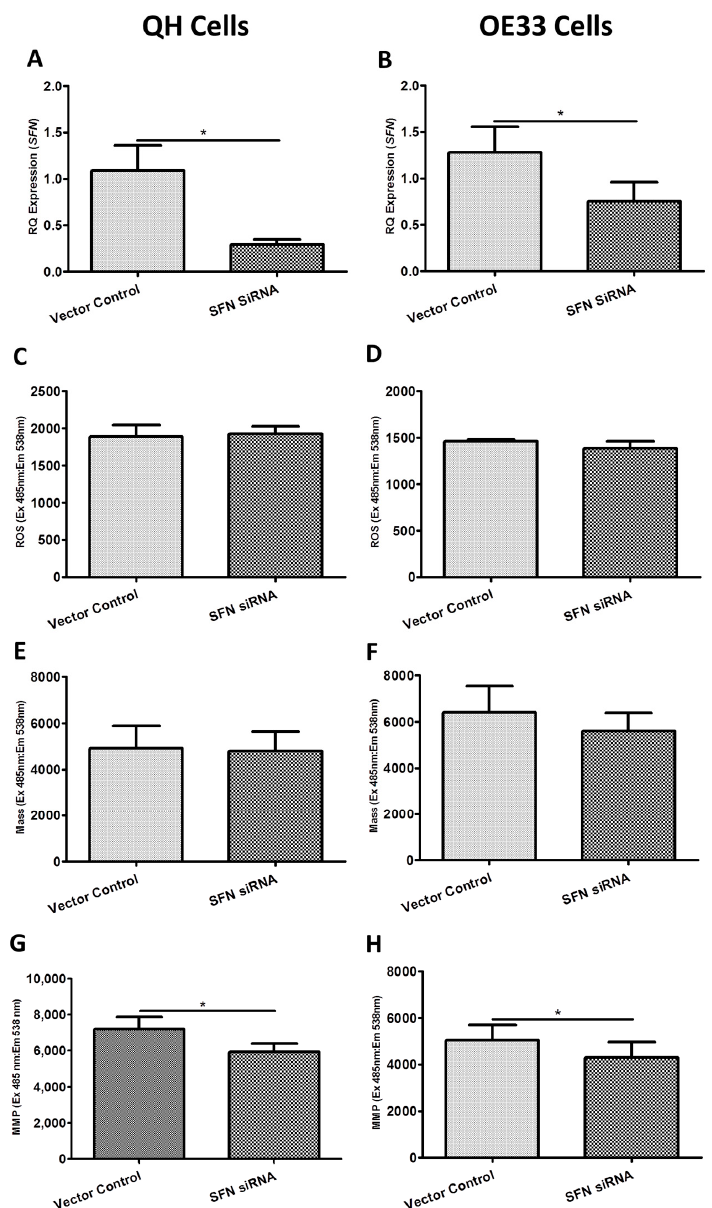
Figure 5. Functional effect of SFN siRNA knockdown on reactive oxygen species (ROS) production, mitochondrial mass and mitochondrial membrane potential (MMP) in the QH (Barrett’s) and OE33 (adenocarcinoma) cell lines in vitro. ( A ) SFN gene expression was significantly knocked down (73%) in the SFN -siRNA treated QH cell line ( p = 0.0495). ( B ) SFN gene expression was significantly knocked down (41%) in the SFN- siRNA treated OE33 cell line ( p = 0.0247). ( C ) SFN knockdown had no significant effect on ROS production in QH ( p = 0.5619) or ( D ) OE33 cell lines ( p = 0.3371). ( E ) SFN knockdown had no significant effect on mitochondrial mass in QH ( p = 0.7858) or ( F ) OE33 cell lines ( p = 0.1431). ( G ) SFN knockdown significantly decreased MMP in the QH ( p = 0.049) and ( H ) OE33 cell lines ( p = 0.0224). Paired t -tests assessed statistical differences between vector control and siRNA treated QH ( n = 4) and OE33 ( n = 3) cells. Bars denote mean ± SEM. * p <